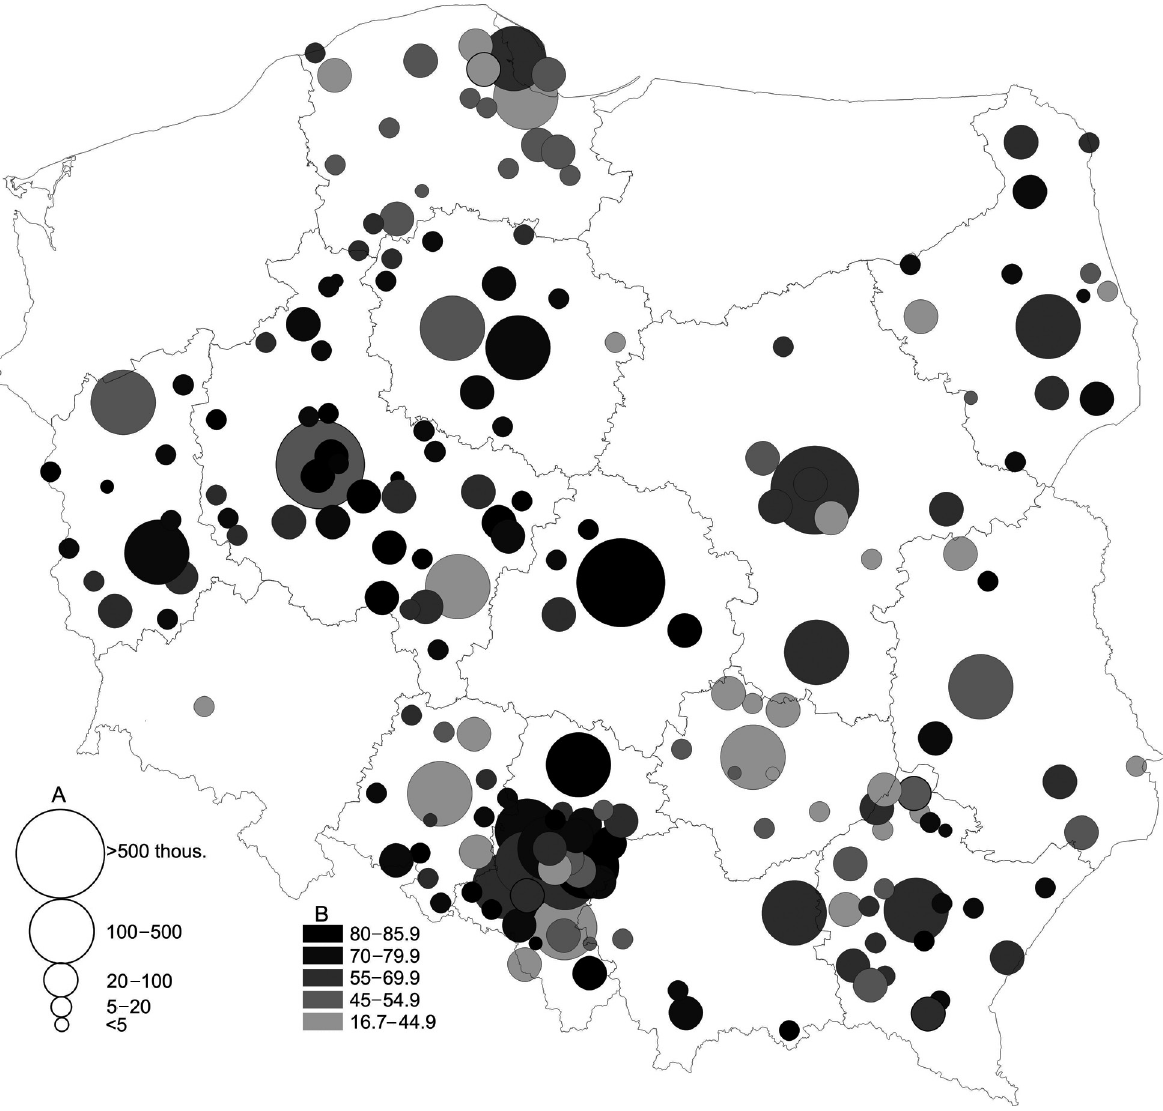
fig. 4. EU’s financial contribution to TI projects involving public buildings in Polish towns subsidised by the rOPV (2007– 2013), as of 31 December 2012. Explanation: A – town-size structure by population number; B – EU’s financial contribution to thermal improvement projects involving public buildings in Polish towns subsidised by the rOPV (2007–2013). Source: developed by the authors on the basis of data available from the lDB CSO and European funds